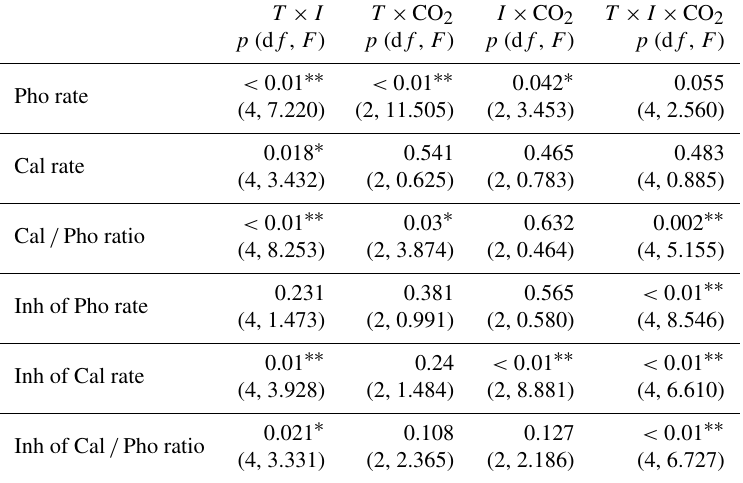
Table 3. Three-way ANOVA analyses of interactive effects among p CO 2 (CO 2 ), temperature ( T ) and irradiance ( I , including P, PA and PAB) on photosynthetic carbon fixation rates, calcification rates and Cal / Pho ratios, respectively. Also shown are three-way ANOVA analyses of interactive effects among CO 2 (CO 2 ), temperature ( T ) and irradiance ( I , including UVA, UVB and UVR) on the inhibition (Inh) of photosynthesis (Pho), calcification (Cal) and the Cal / Pho ratios,